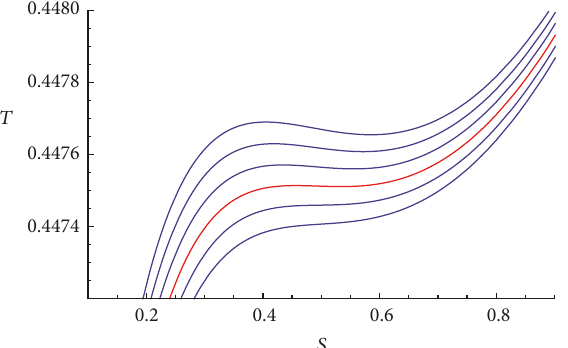
Figure 2: Relations between temperature and thermal entropy for different 𝑒 with 𝑞 = 0.05 ; curves from top to down correspond to cases 𝑒 varying from 0.1385 to 0.139 with step 0.0001.